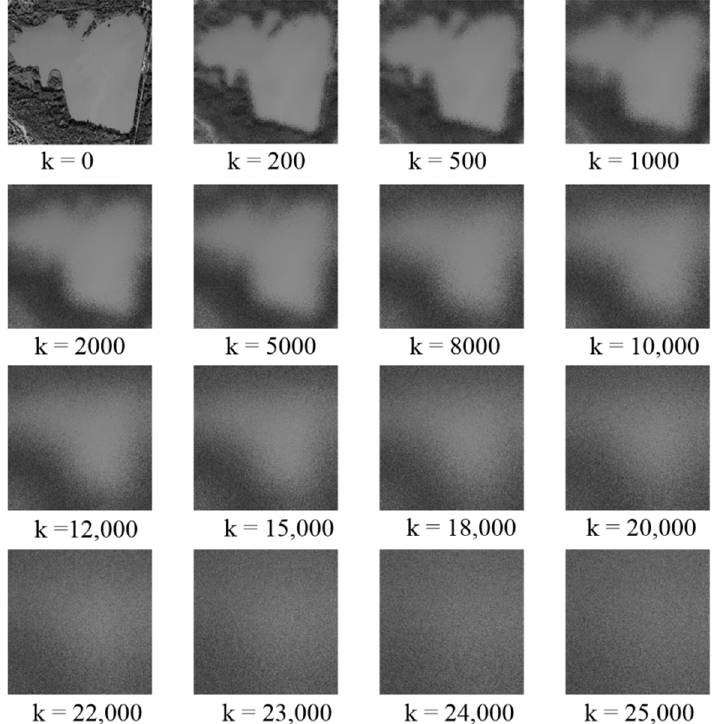
Figure 13. Original image and simulated images with an increasing thermodynamic disorder. These images are the outcomes of the iterations and k is the number of iterations.